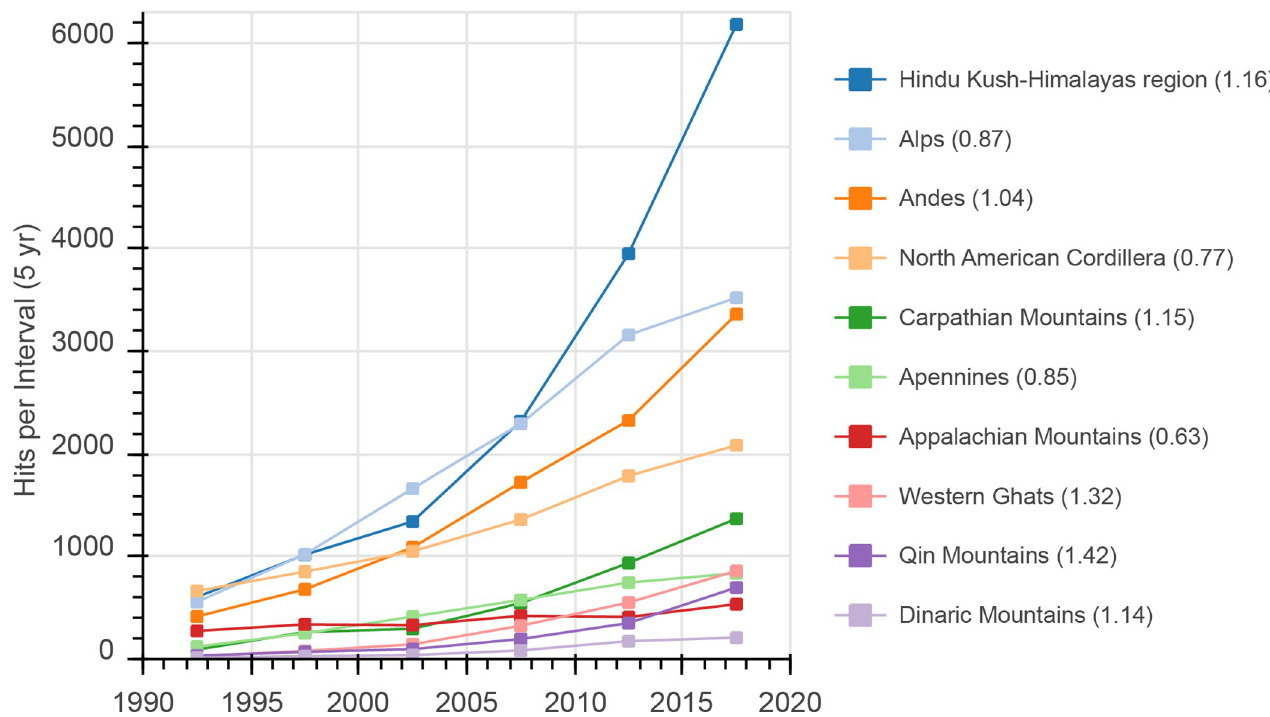
Fig 5. Number of hits for the Top 10 ranges for 5-year intervals from 1990–2019. Number in brackets is the Trend Index (see Eq 1) for 2015–2019.